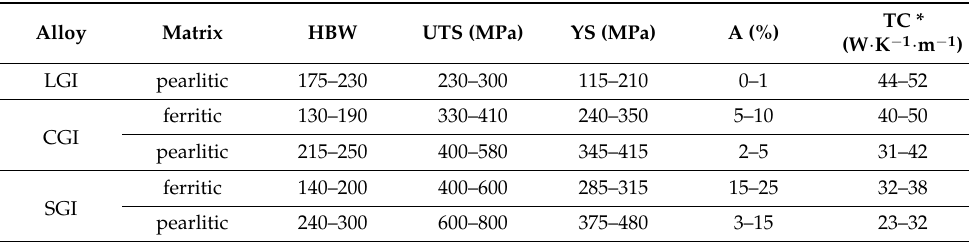
Figure 77. ( a ) Microstructure of compacted graphite iron; ( b ) microstructure of a spheroidal graphite iron with worms at about 15% in the area. Table 2. Comparison of hardness, tensile properties and thermal conductivity ranges in grey irons, compacted irons and ductile irons with both pearlitic and ferritic